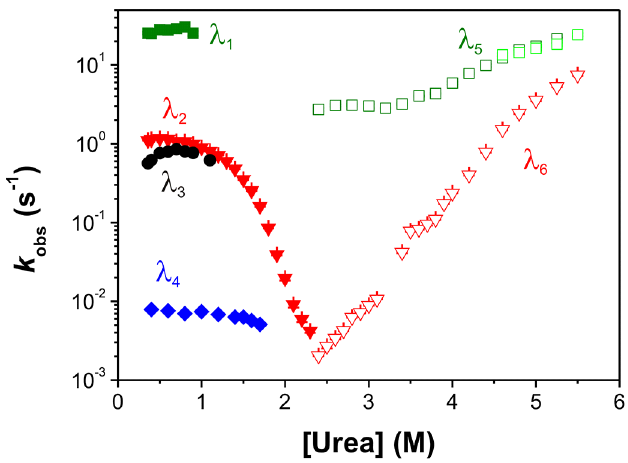
Fig 4. Chevron plot for the fluorescence detected un- and refolding kinetics. Urea-dependence of the apparent refolding and unfolding rate constants of N-BAR measured by fluorescence: open symbols represent unfolding kinetics, green squares show the fast unfolding phase measured with double mixing experiments, light green squares show the fast unfolding phase measured with single-mixing experiment above 4.4 M urea, red triangles show the slow unfolding phase measured with single-mixing stopped-flow and below 3.5 M urea by manual mixing experiments. Closed symbols represent refolding kinetics, green squares, red triangles and black circles show single-mixing stopped-flow kinetics. Blue diamonds symbolize very slow kinetics from manual mixing experiments.